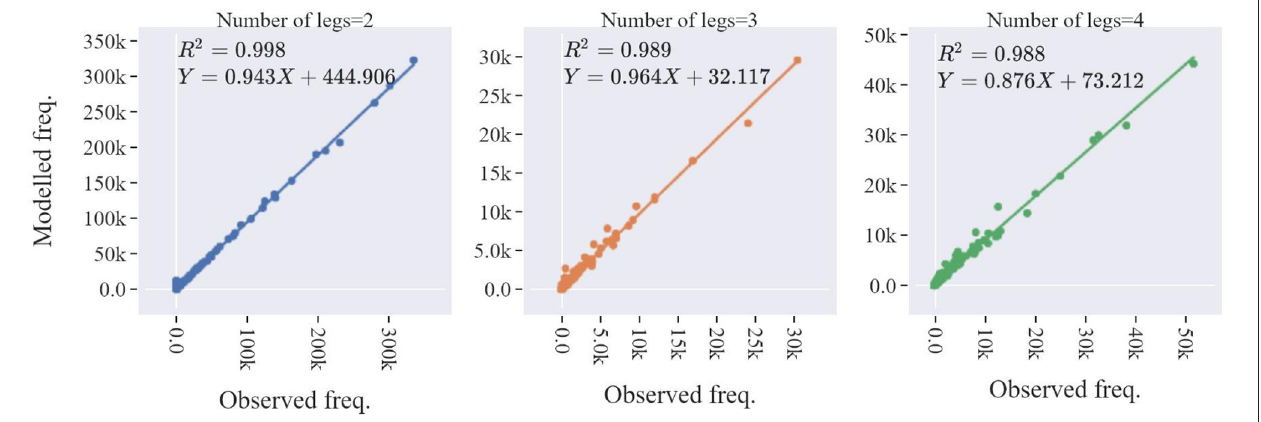
FIGURE 10 | Scatter plot comparison of the calibration distribution by number of legs.